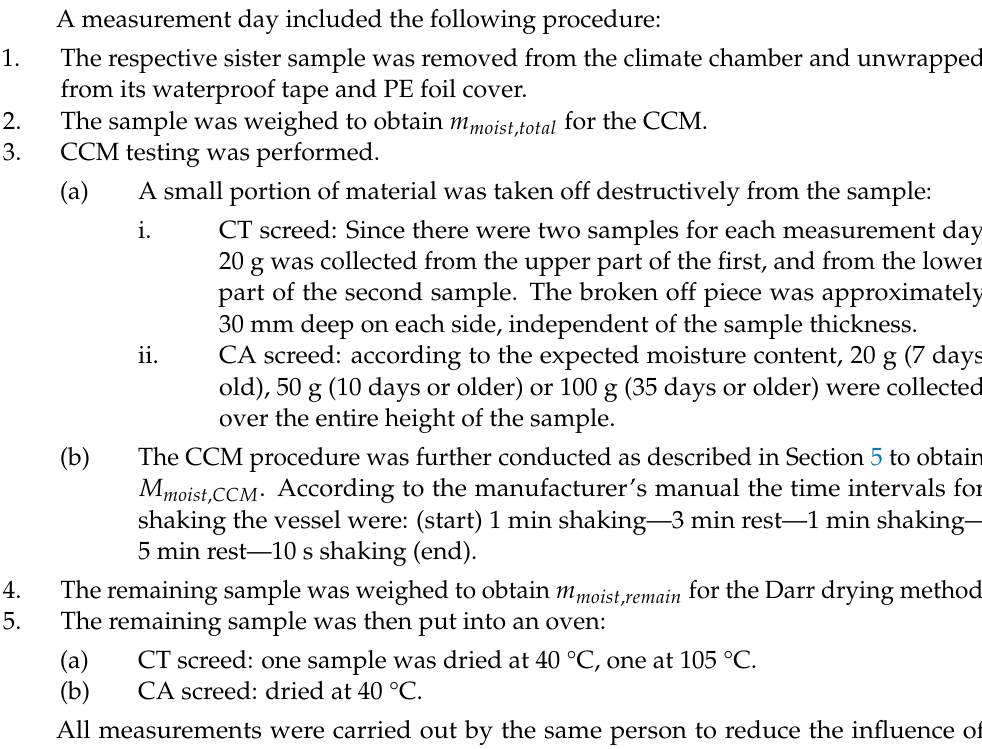
Figure 2. Formwork ( left ) to cast the resulting screed sister samples ( right ) of 100 mm diameter and varying heights h of 50 mm, 60 mm and 70